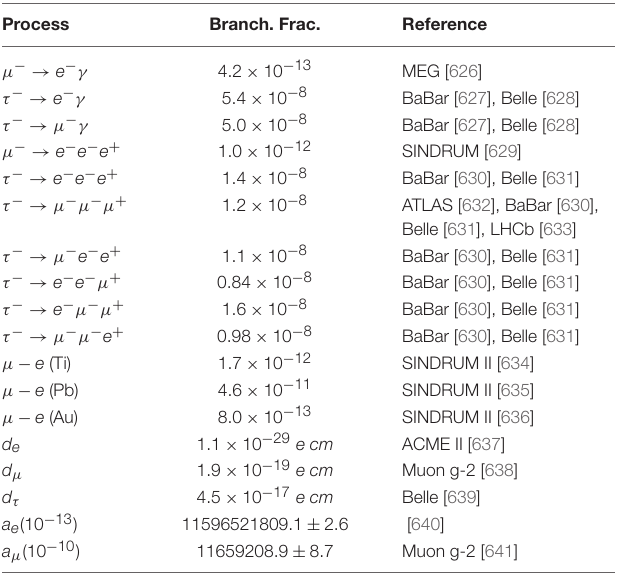
TABLE 2 | Upper bounds at 90 % C.L on LFV processes and EDMs, and measurements of AMMs, along with the experiments that provided them. Process Branch. Frac.